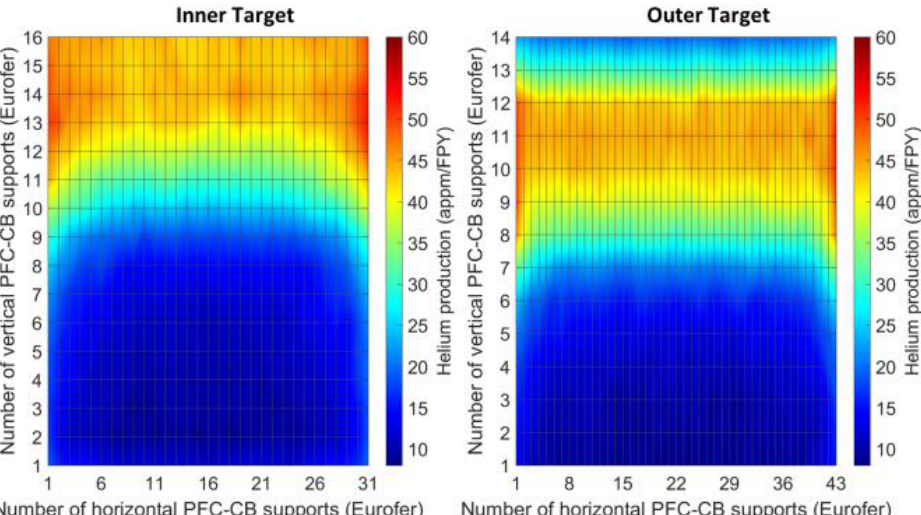
Figure 28. He-production (appm/FPY) distribution on PFC-CB supports (Eurofer) of the inner ( left ) and outer ( right ) target, with HCPB blanket.